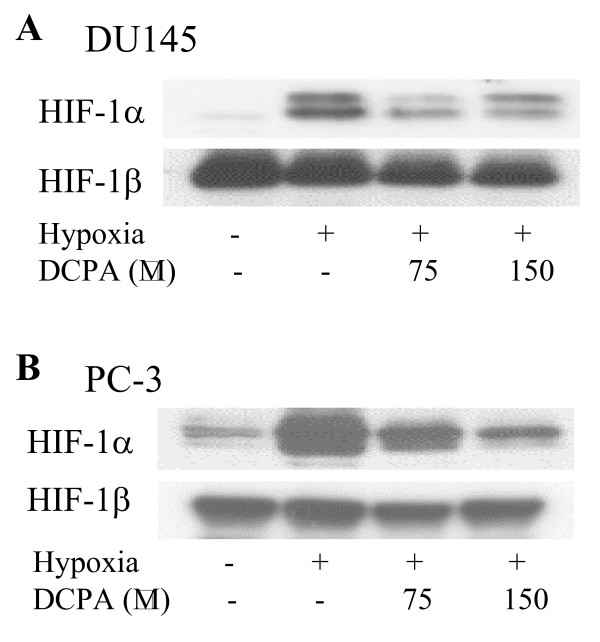
Expression of HIF-1α was specifically induced by hypoxia, and inhibited by the treatment of DCPA. DU145 (A) and PC-3 (B) cells were cultured in complete medium in the presence of 0, 75, or 150 μM DCPA for 24 h, followed by the incubation with 20% or 1% O2 (hypoxia) for 6 h. Total cellular protein extracts were prepared from these cells, and aliquots of the extracts were used for the immunoblotting analysis.